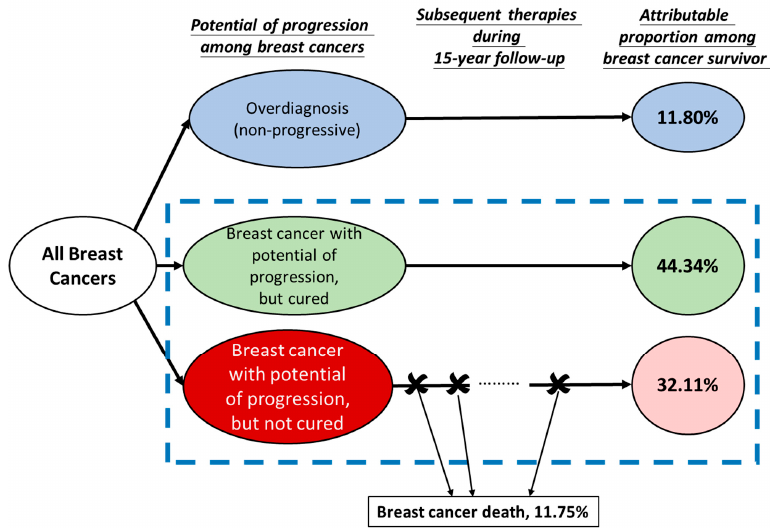
Figure 1. Study design for estimating the proportion of breast cancer survivors attributed to overdiagnosis, the completely cured after initial treatment, and the curation after subsequent therapies during 15-year